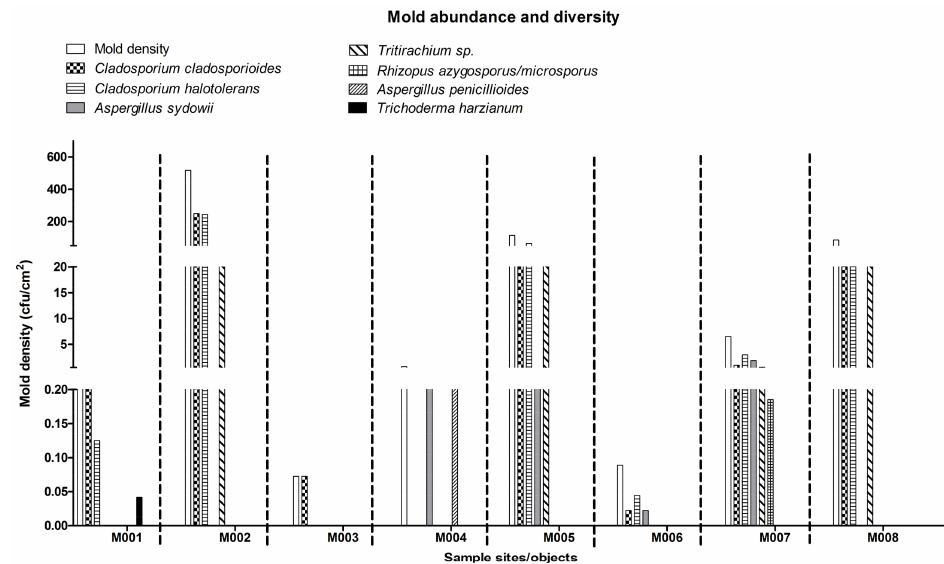
Figure 3. Mold abundance and diversity in each sample